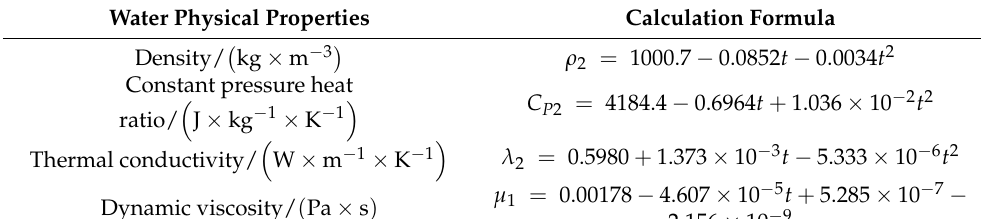
Table 2. Water parameters.